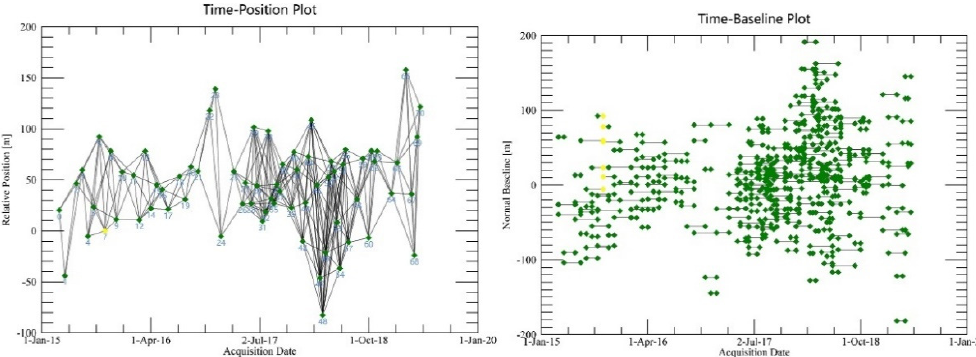
Figure 3. Schematic of the Small Baseline Subset (SBAS) configuration of the Sentinel-1A images.